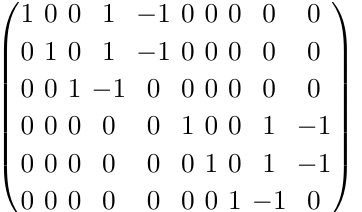
^ P and P ^ P to intersect, see also 1 2 3 4